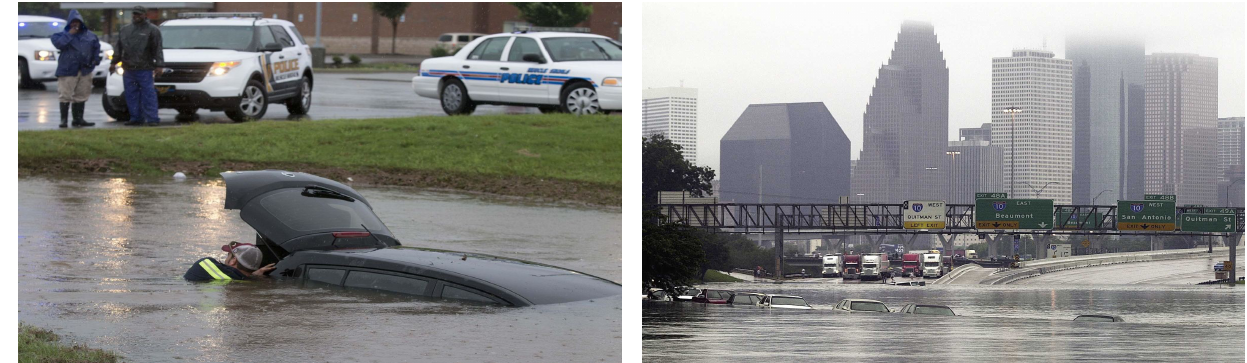
Figure 3. Shows two images from flood dataset with varying flood height in the